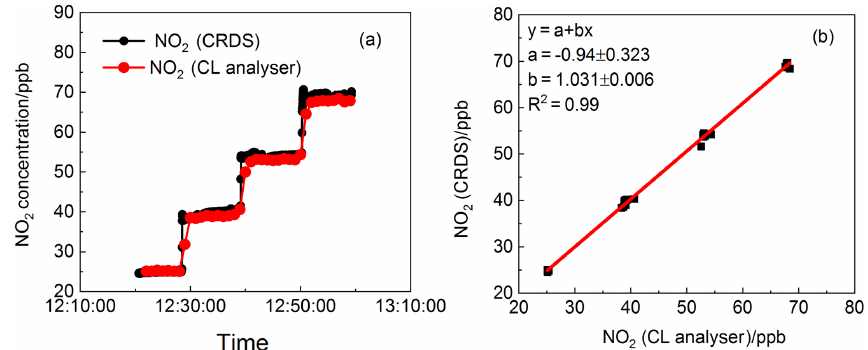
Figure 7. (a) Time series of NO 2 concentration standard mixtures sampled by the CRDS instrument and CL analyser. The time resolution for the CRDS instrument and CL analyser are 1s and 1min, respectively. (b) A correlation plot between the data from the CRDS instrument and the CL analyser (data averaged to 1min). The fitting result gave a gradient of 1.031 and an intercept of − 0 . 940ppb, with a linear correlation factor of